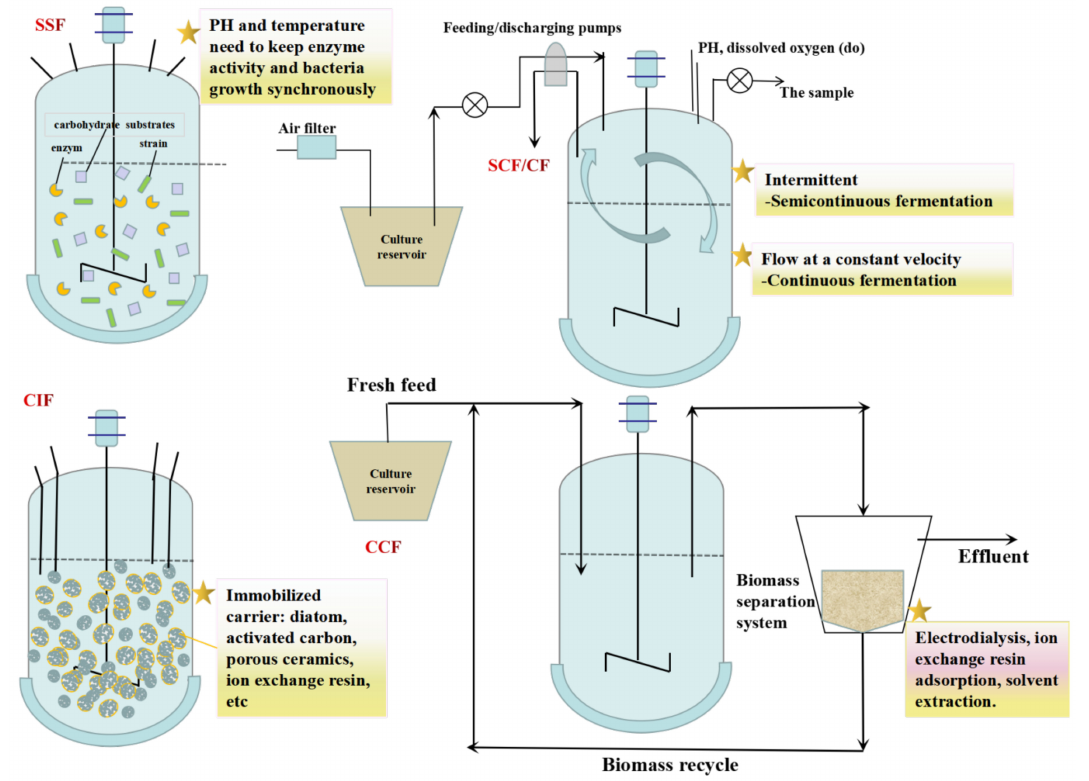
Figure 3. Fermentation modes for L-LA